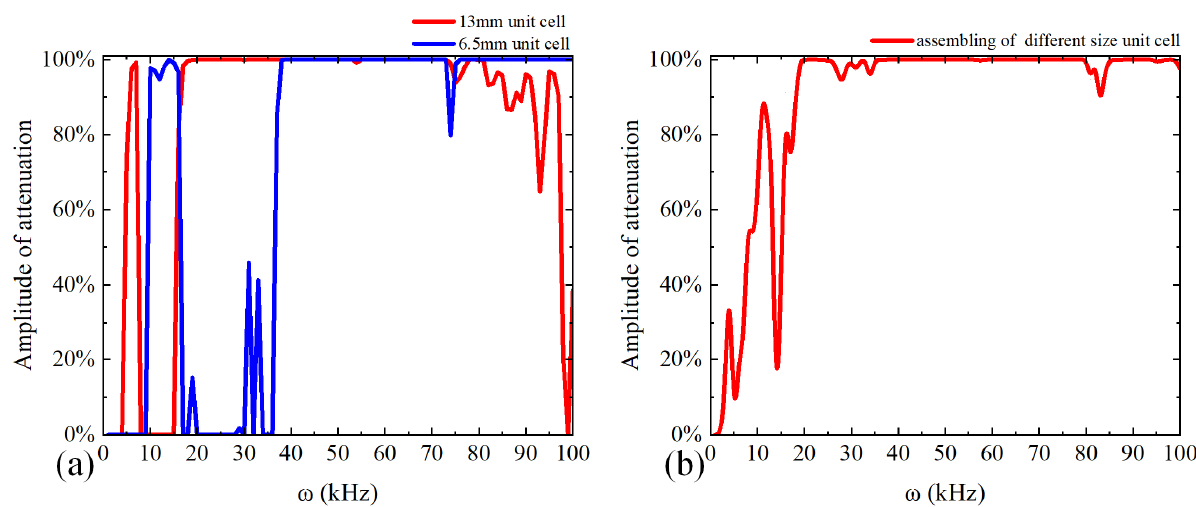
Figure 9. The velocity frequency response curve of the proposed plate-type elastic metamaterial with the frequencies of 0~100 kHz. ( a ) The plate metamaterial consisting of 6.5 mm unit cell and 13 mm unit cell, where the blue velocity frequency response curve represents 6.5 mm unit cell and the red velocity frequency response curve represents 13 mm unit cell; ( b ) the plate metamaterial which assembled the different size unit cell.